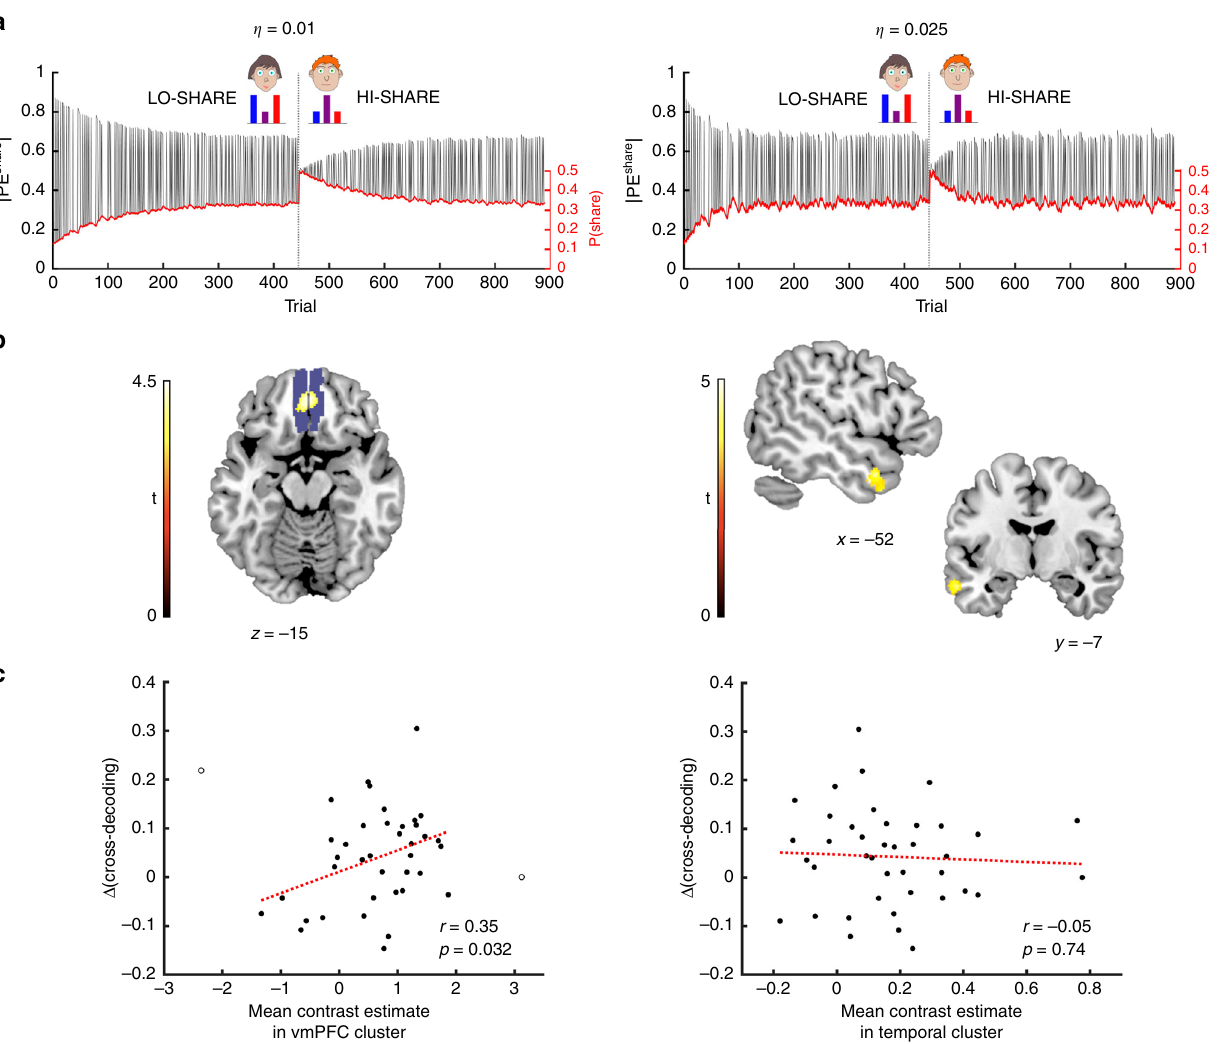
Fig. 5 Probability of sharing information between Self and Other is tracked in vmPFC and temporal pole. a Example regressors from a learning model that tracks the probability of encountering a ‘ shared ’ trial, P(share). The red line indicates P(share) whilst the black line indicates the PE magnitude from this model. The sharp boundary, at trial 444, indicates that this particular subject did the Lo-Share task, followed by Hi-Share. Left: Regressors generated with a learning rate ( η ) of 0.01. Right: Regressors generated with η of 0.025. b Left: P(share), at η = 0.01, is tracked in bilateral vmPFC. Blue shading shows the mask used for small-volume correction. Right: P(share), at η = 0.025, is tracked in left temporal pole. Clusters were de fi ned with a cluster-forming threshold of p < 0.001. Only clusters that were large enough to survive FWE-correction at p < 0.01 are displayed (additional FWE correction was applied to account for testing multiple η values). One-sided t-contrasts on n = 40 independent subjects. t-statistics are shown in the colour bars. c Left: Mean contrast estimates in vmPFC cluster are positively correlated with the difference in Self-Other cross-decoding between the Hi- and Lo-Share conditions, after excluding two subjects with extreme contrast estimates (empty circles). Pearson correlation: r = 0.35 p = 0.032. Right: Mean contrast estimates in the temporal cluster are not correlated with the difference in Self-Other cross-decoding between the Hi- and Lo-Share conditions. Pearson correlation: r = − 0.05 p = 0.74. Source data are provided as a Source Data fi